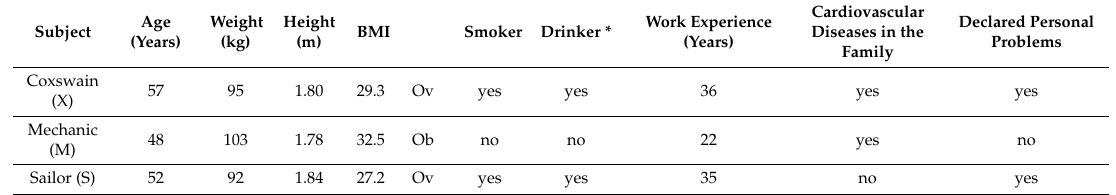
Table 1. Characteristics of the subjects.